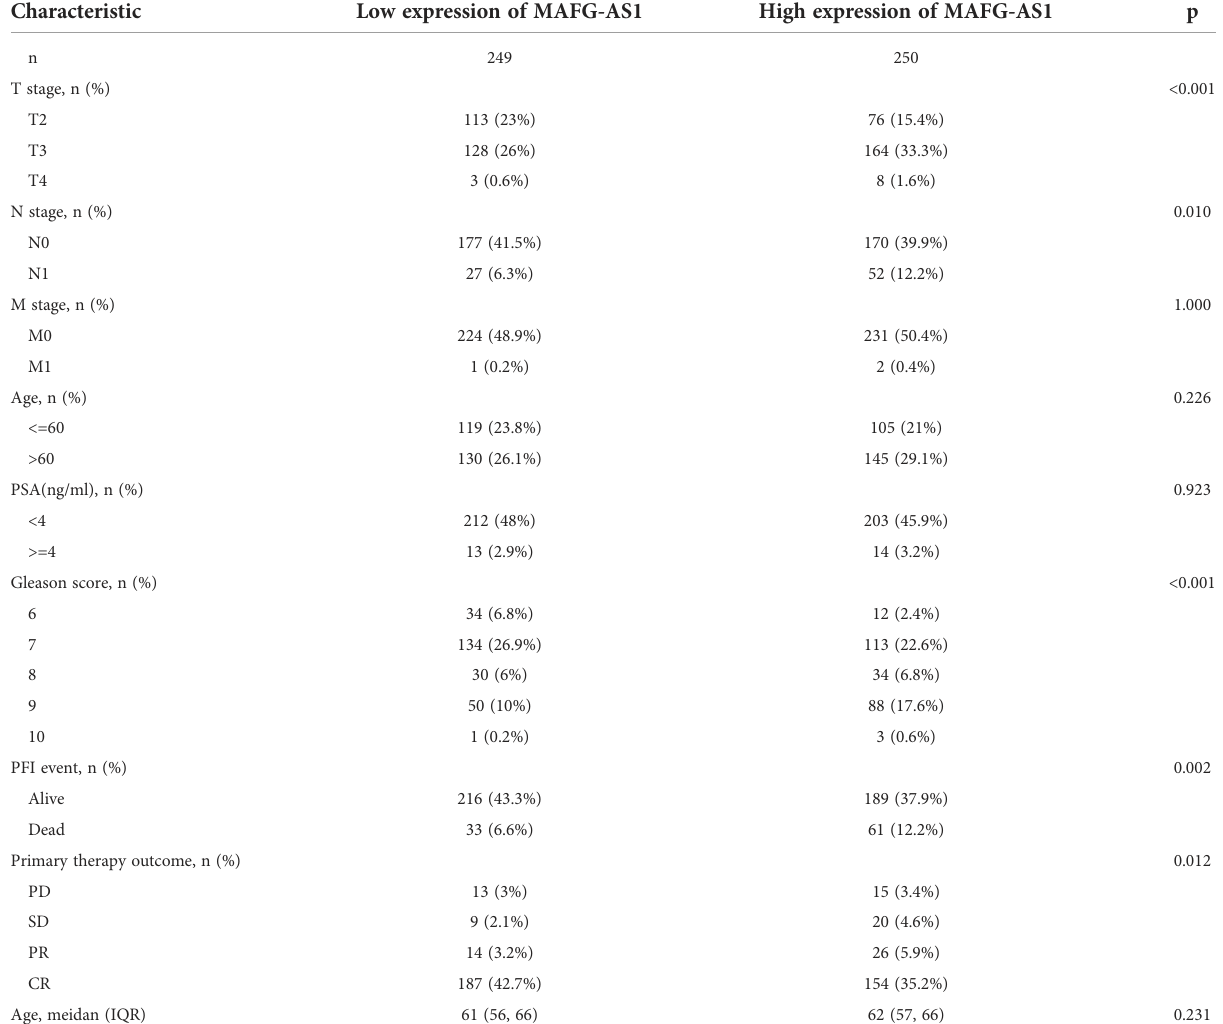
TABLE 1 Correlation between MAFG-AS1 expression and clinicopathological characteristics of prostate cancer.